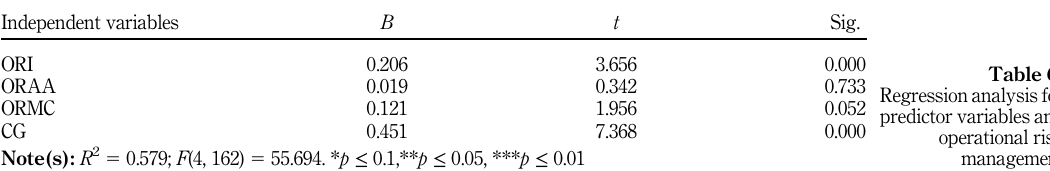
Table 6. Regression analysis